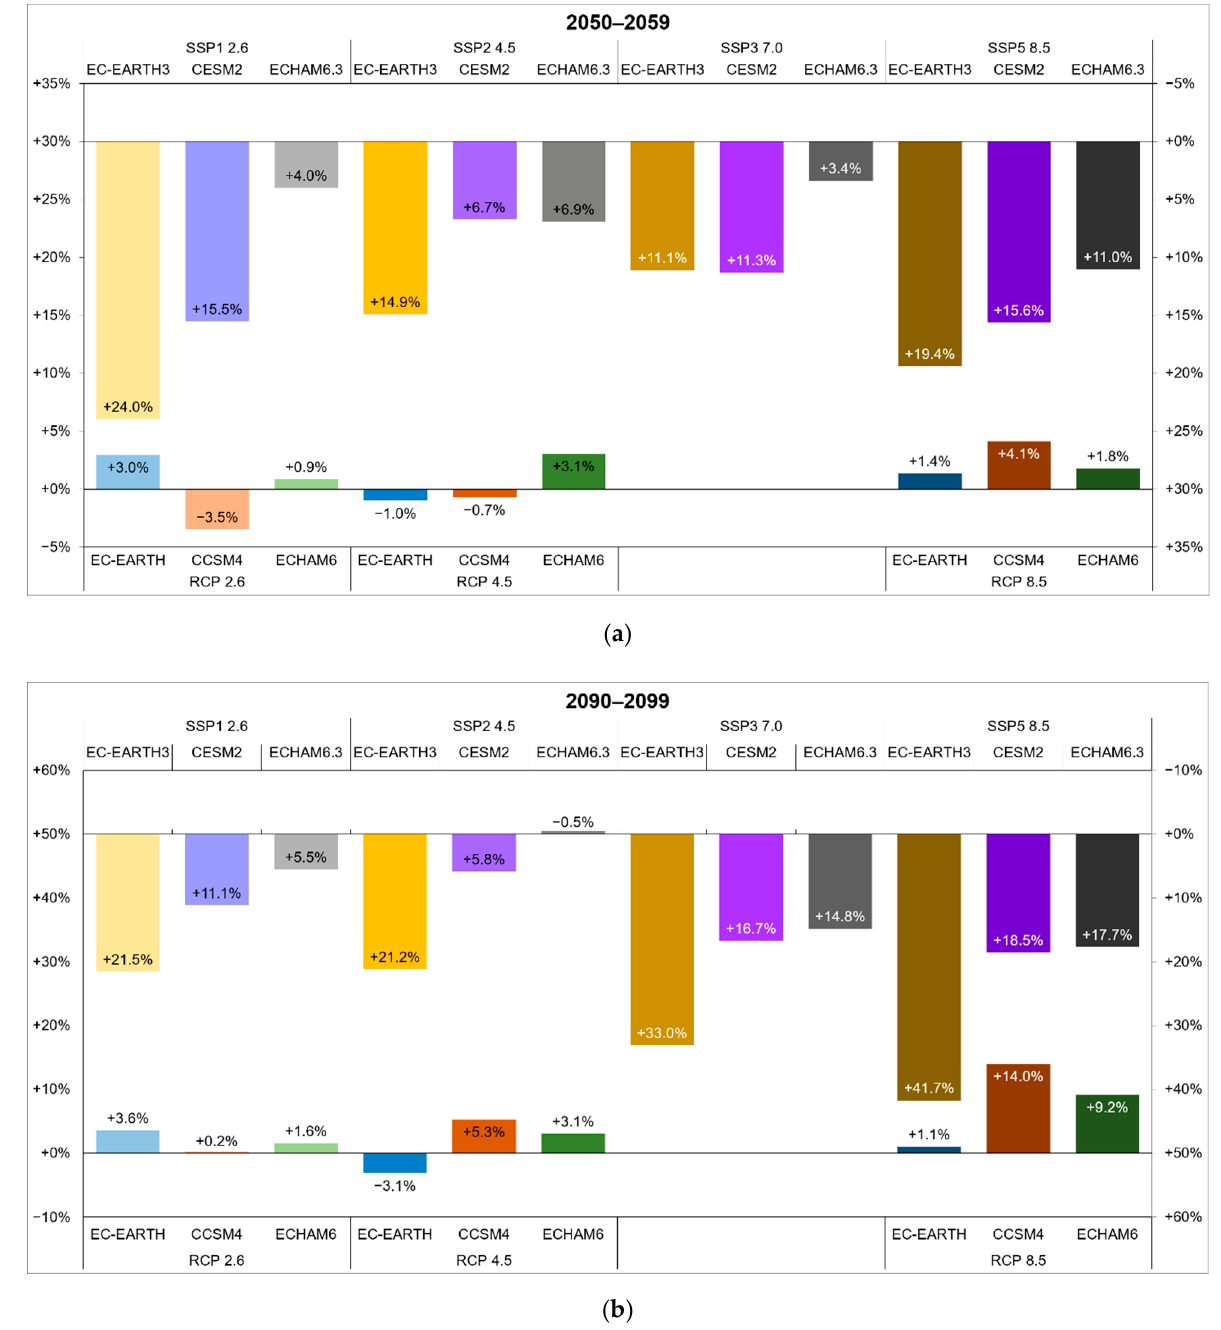
Figure 7. Average yearly precipitation variations. ( a ) Mid Century P1. ( b ) End of Century P2.